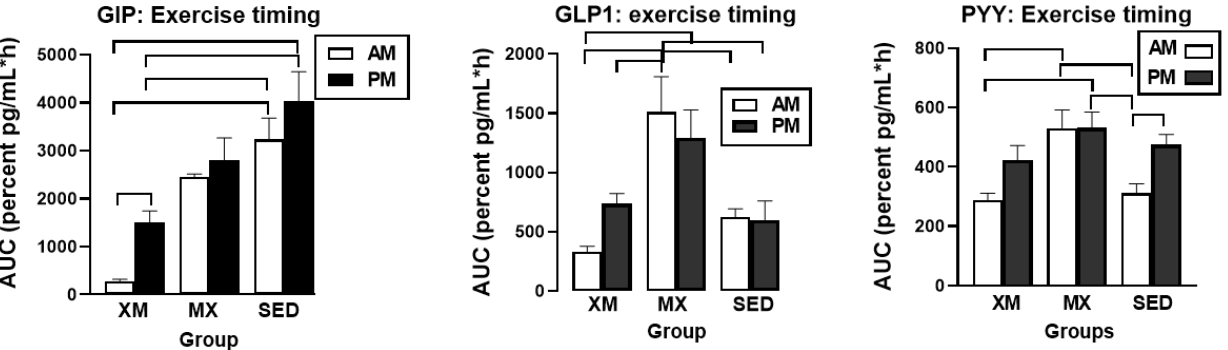
Figure 12. Exercise- and meal-timing effects on GIP, GLP-1, and PYY AUCs. Brackets identify significant between- and within-group differences. Morning as well as evening SED GIP AUCs were significantly higher than AM and PM XM AUCs ( left panel). Morning MX GLP1 AUC was significantly higher than AM XM AUCs and AM and PM SED AUCs Evening MX GLP1 AUC was significantly higher than AM XM and SED AUCs ( center panel. Morning MX PYY AUC was significantly higher than AM XM and SED AUCs ( right panel). EX = exercise, XM = exercise before meals, MX = exercise after meals, SED = sedentary